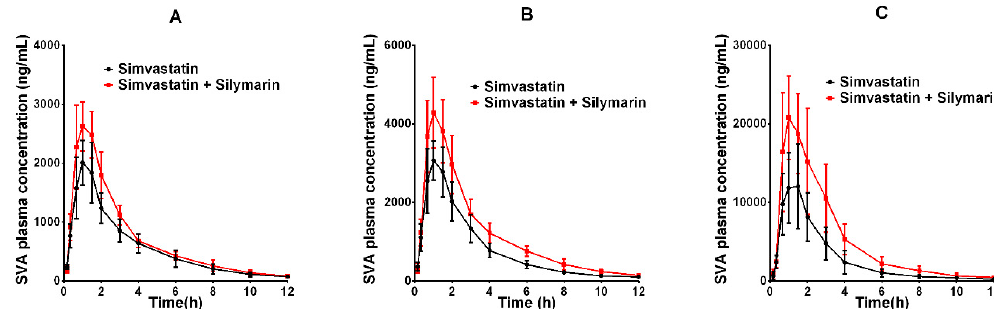
Figure 3. The pharmacokinetic profiles of SVA in rats after oral administration of di ff erent doses of SV with or without treatment with silymarin (45 mg / kg). ( A ) Dose of SV at 20 mg / kg; ( B ) dose of SV at 40 mg / kg; ( C ) dose of SV at 80 mg /